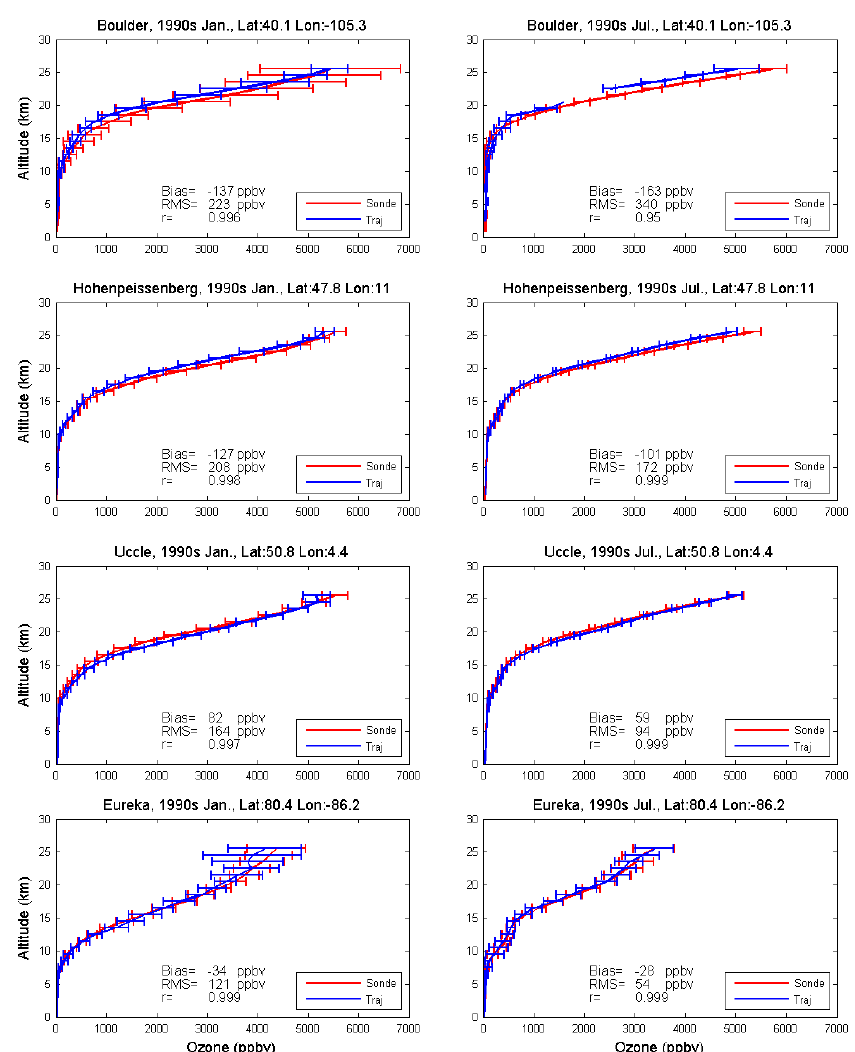
Fig. 2a. Ozone profiles at Boulder, Hohenpeissenberg, Uccle, and Eureka: decadal monthly means in January (left) and July (right) in the 1990s. The actual sounding profiles are labeled “Sonde” in the panels, while the profiles from trajectories without input from the station being tested are labeled “Traj”. The error bar is 4 times the standard error of the mean (equivalent to 95% confidence limits on the averages). The RMS is the root mean square and r is the correlation coefficient.